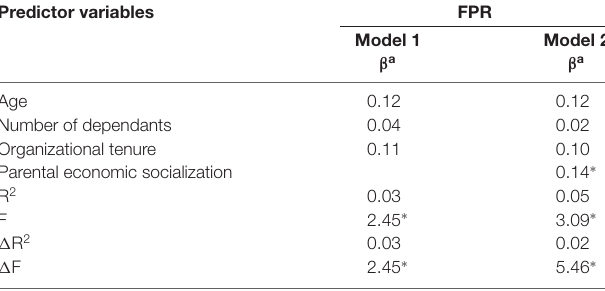
TABLE 2 | Linear regression analysis on